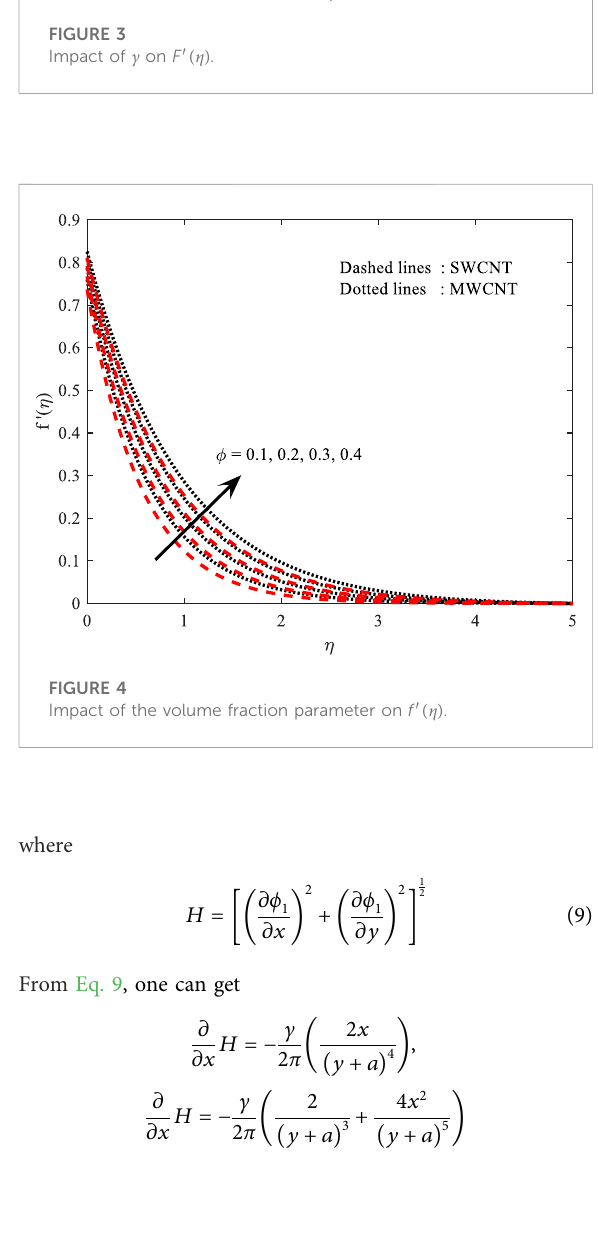
FIGURE 5 Impact of the volume fraction parameter on F ′ ( η ) .